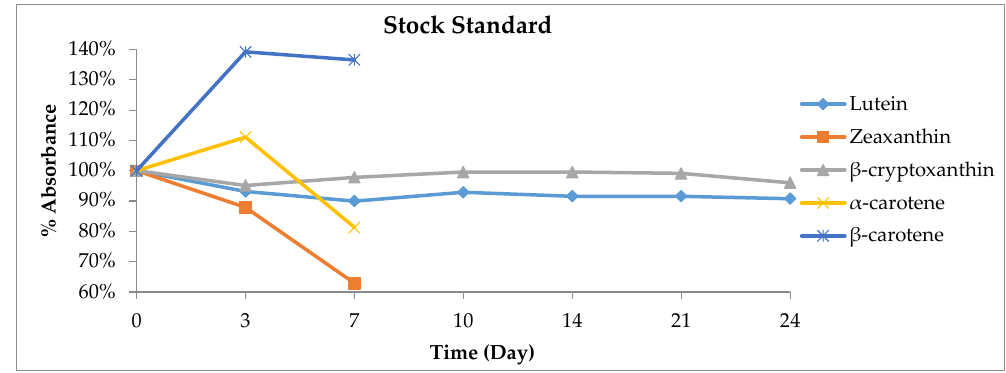
Figure 5. UV absorbance of carotenoids standard stock solutions at different time points. All standard solutions were stored at − 70 °C prior to analysis. Y axis: Measured absorbance by UV spectrometer compared to the reading from 0-time (normalized to percentage). X axis: Testing time point.